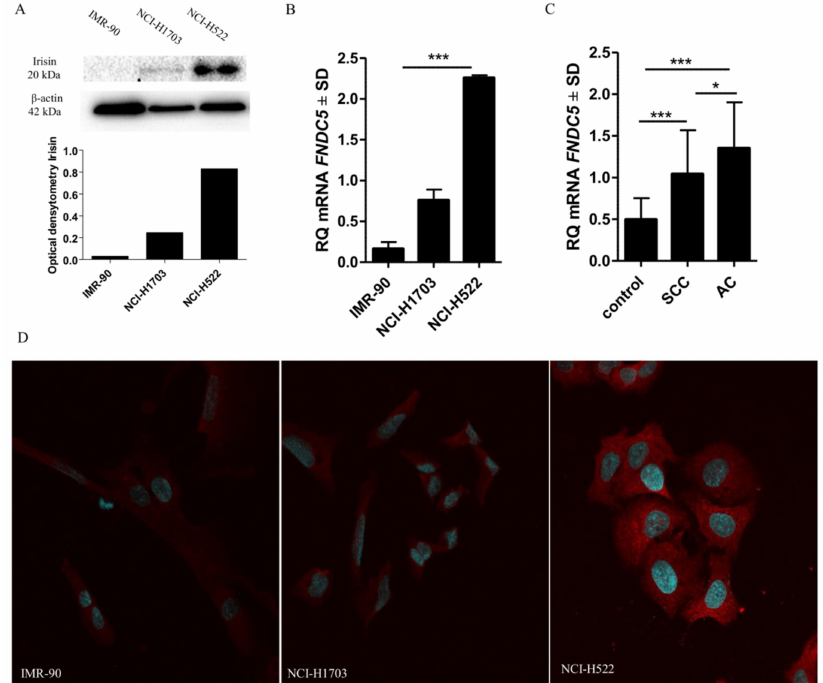
Figure 4. Comparison of irisin expression levels detected by Western-blot ( A ) and mRNA of FNDC5 ( B ) by confocal microscopy ( D ) in normal fibroblast (IMR-90) and di ff erent cancer cell lines (NCI-H1703, NCI-H522). Comparison of mRNA FNDC5 expression levels detected by real-time PCR in healthy lung tissues and di ff erent subtypes of NSCLC ( C ) ** p ≤ 0.005, *** p ≤